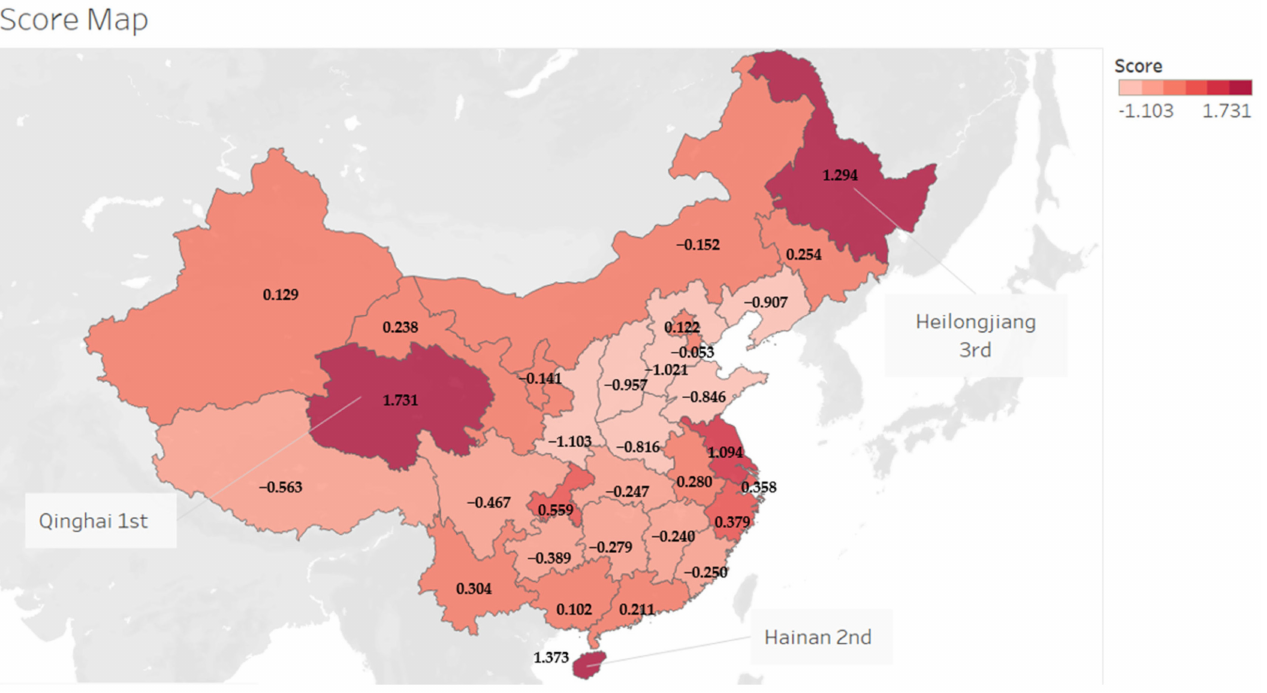
Figure 8. Construction accident evaluation score of 31 regions in